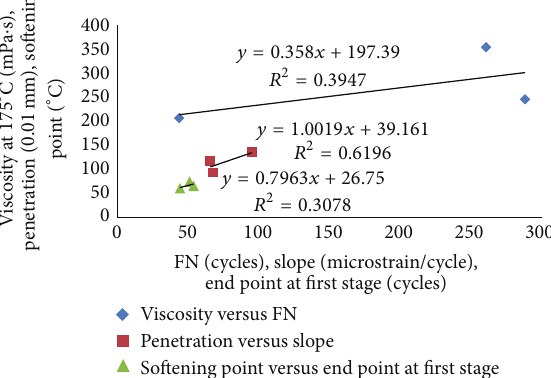
Figure 9: Characteristics of binders versus parameters of perma- nent deformation of asphalt